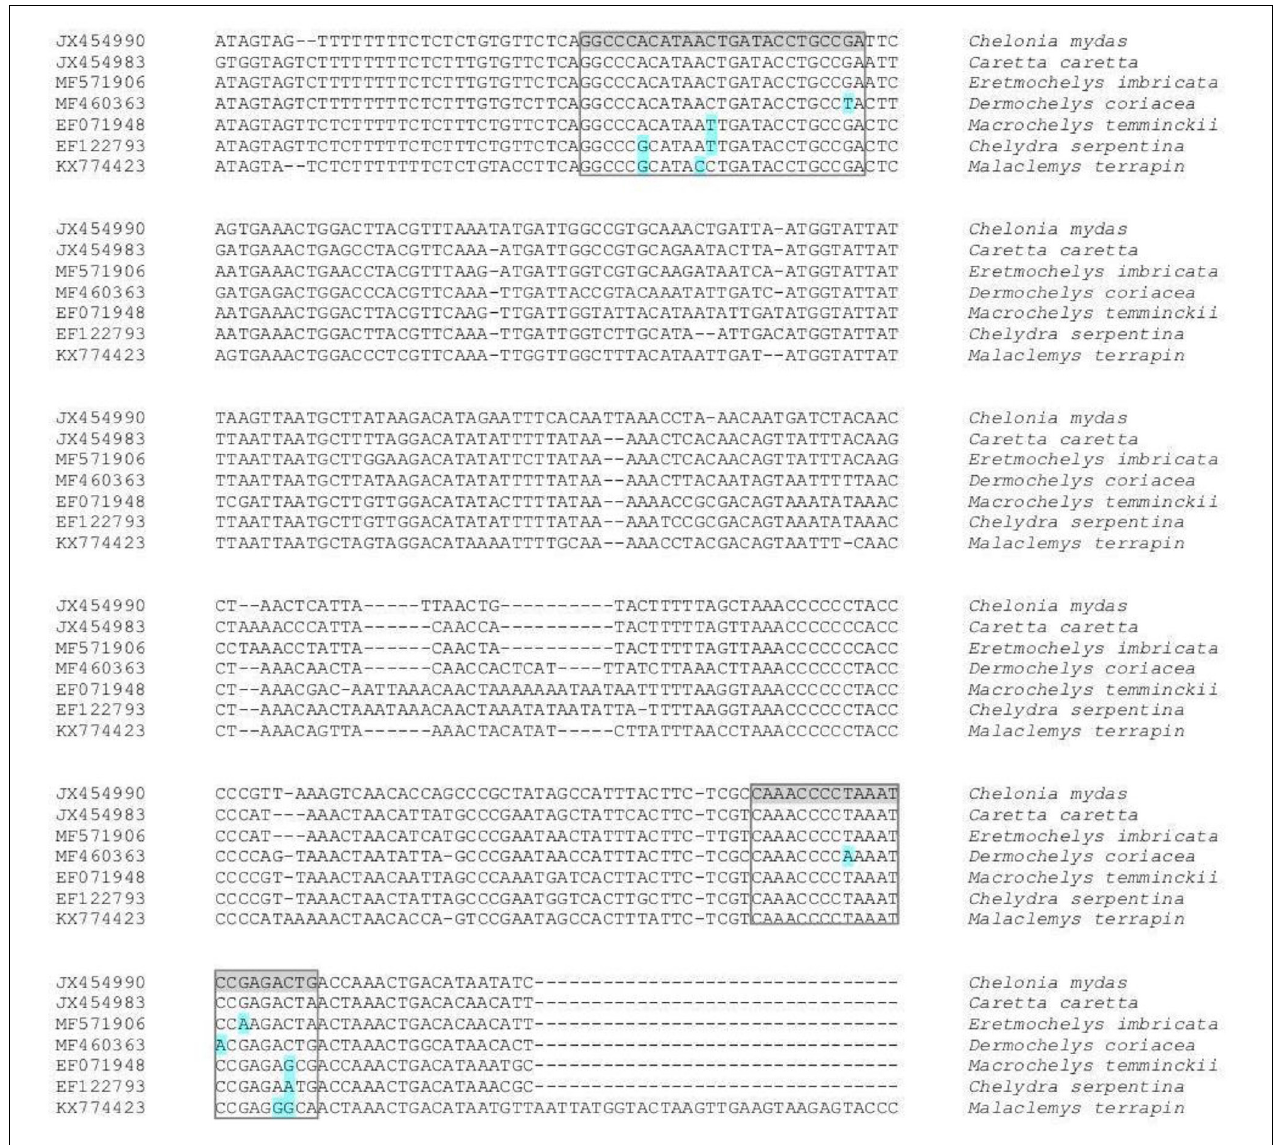
FIGURE 3 | The Chelonia mydas D-loop target region for the primer pair LCMint2/H950g. Forward and reverse primers for LCMint2/H950g are highlighted in grey on a representative D-loop region for Chelonia mydas . In addition, representative D-loop target regions for other sea turtle species with mismatches on either the forward or reverse primers produced by ecoPCR are given. Highlighted nucleotides represent positions where the sequence of any entry differs from the primer (blue highlight). Species shown: Caretta caretta, Eretmochelys imbricata, Dermochelys coriacea, Macrochelys temminckii, Chelydra serpentina, and Malaclemys terrapin